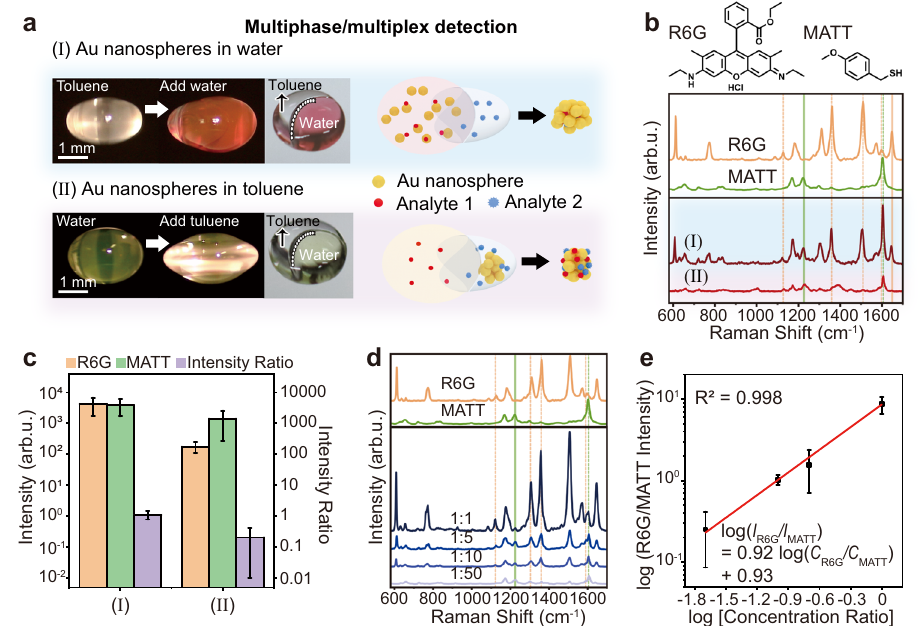
Fig. 3 | Multiphase and multiplex SERS detection. a Introducing water into a levitating toluene droplet, or viceversa. Toluene wrapped oneend of the ellipsoid water droplet. For multiphase and multiplex SERS detection, introducing Au nanoparticles to the water phase facilitated the analytes to enter the Au nano- particle aggregate after solvent evaporation; otherwise, the preaggregated Au nanoparticles in the organic phase hindered the entrance of the analytes, parti- cularly for the analytes in the water phase (refer to the schematics on the right). b SERS spectra of 50nM MATT in toluene and 50nM R6G in water when Au